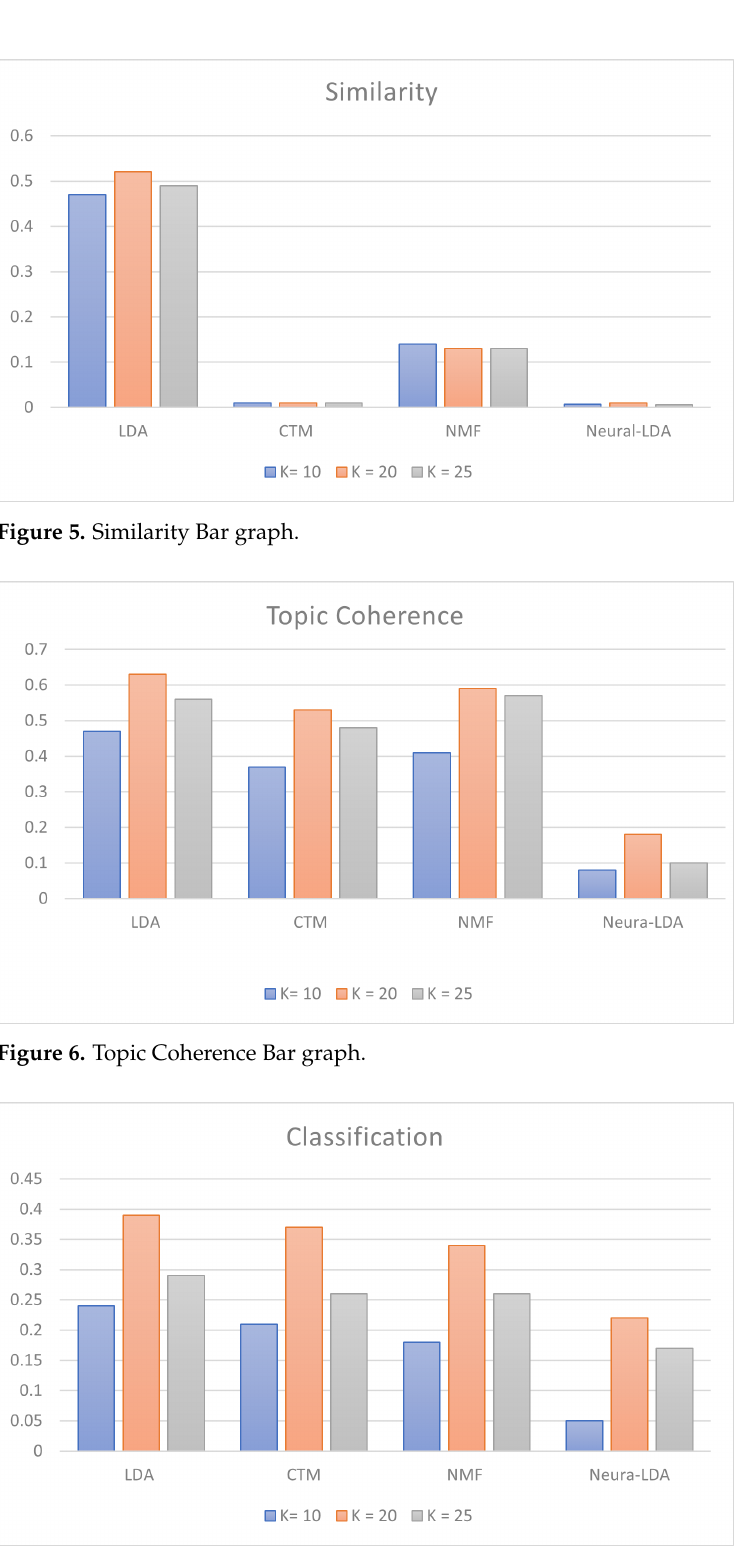
Figure 7. Classification Bar